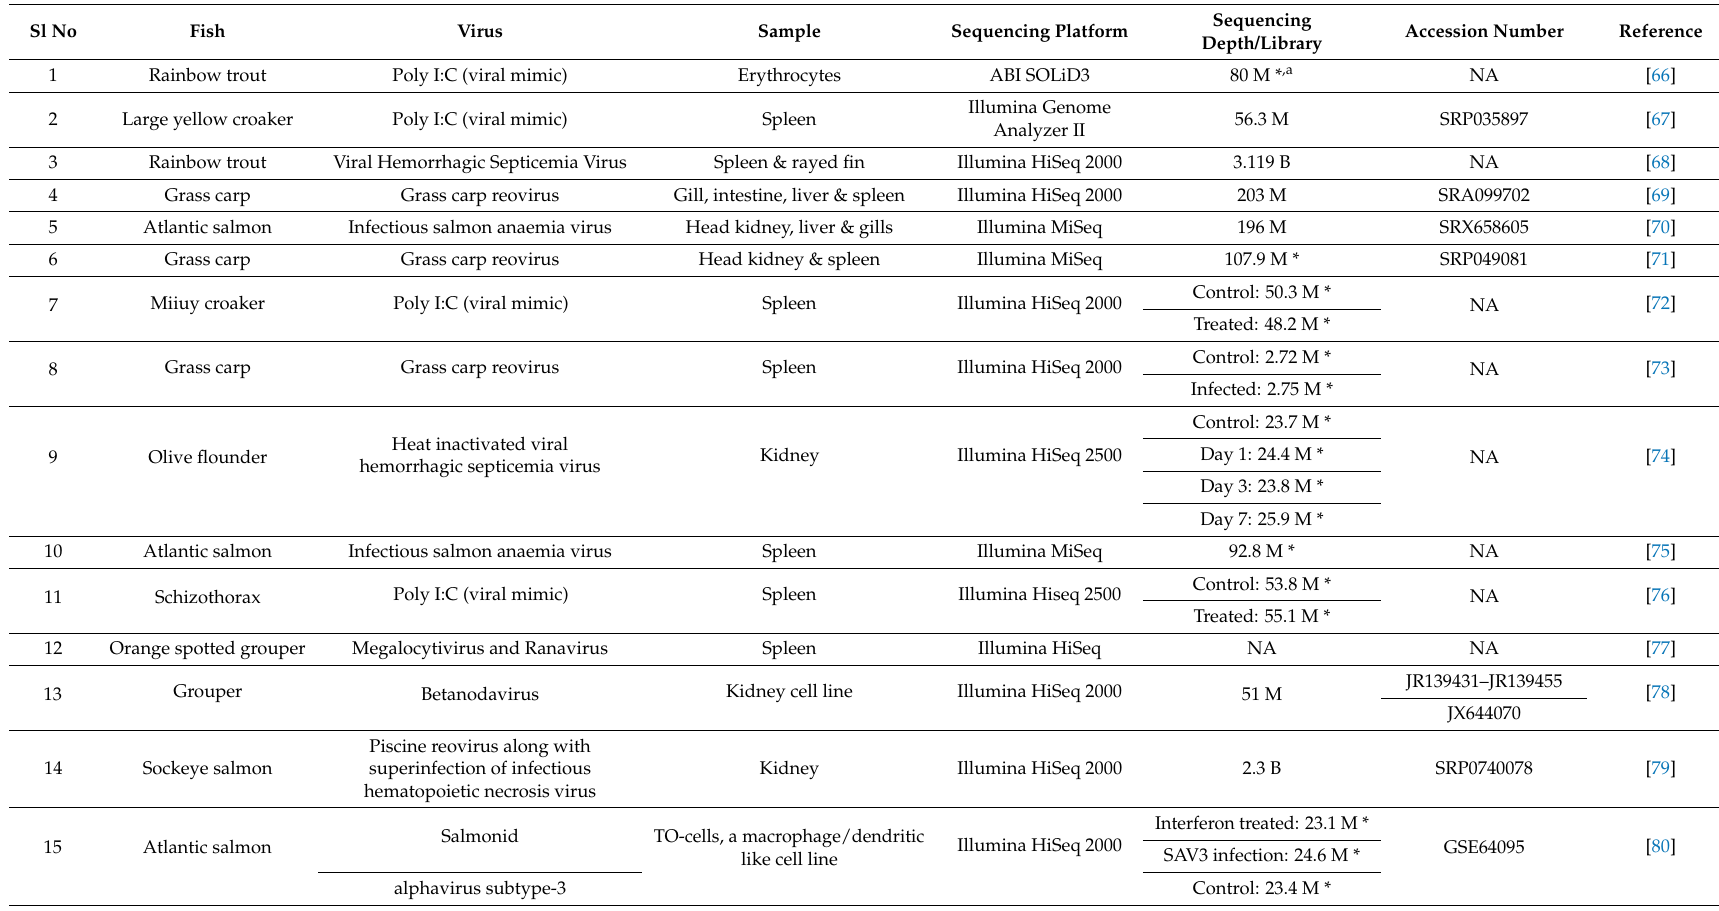
Table 2. RNA-Seq analysis of fish in response to viral pathogens. This table shows a description of transcriptomes to understand viral diseases in various fish